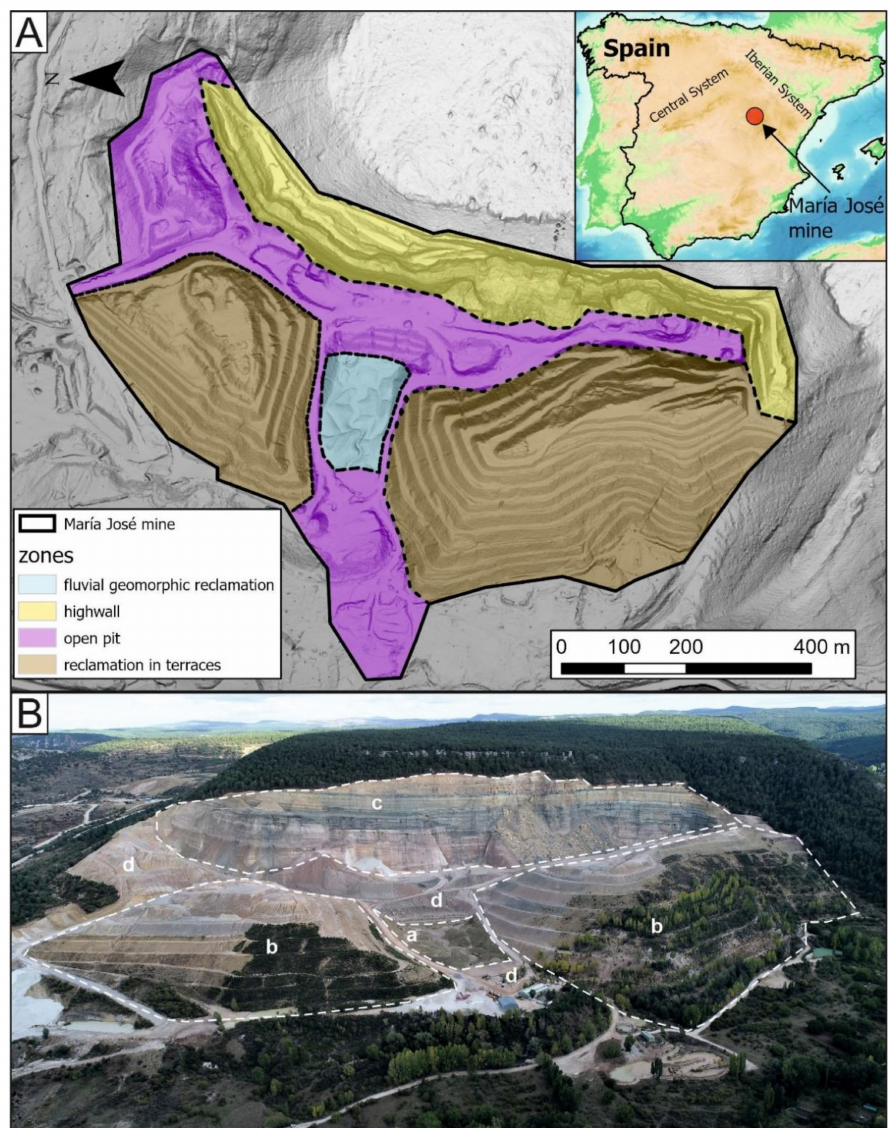
Figure 1. Location and map ( A ), and oblique view of the Mar í a Jos é mine on 15 April 2018 ( B ). The mine is classified into four areas: (a) a fluvial geomorphic-based reclamation; (b) two terraced waste dumps; (c) a highwall; (d) an open pit with ponds, roads and other work areas. Base topog- raphy in ( A ) derived from a LiDAR point cloud provided by the Spanish National Plan for Aerial Orthophotography of 2018; photo by DGDRONE